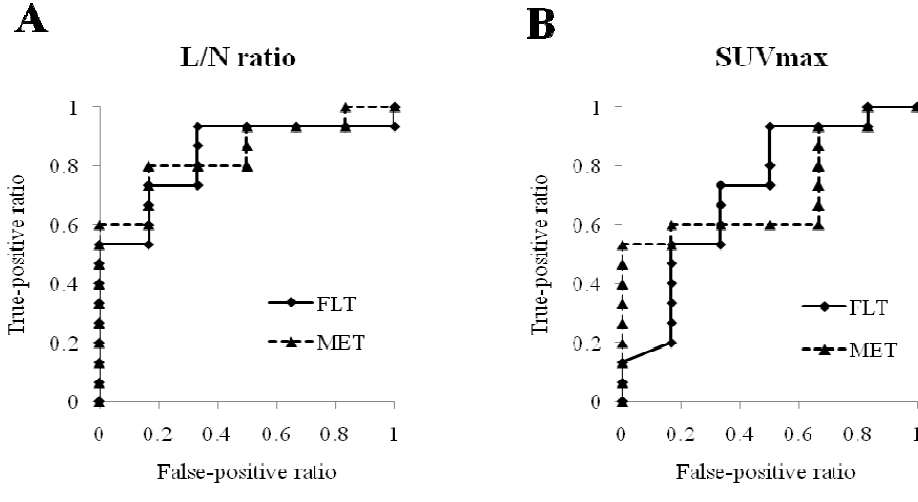
Figure 4. ROC curve indicating that the areas under the curves are not different between tumor uptake values of MET and FLT in both L/N ratio ( A ) and SUVmax ( B